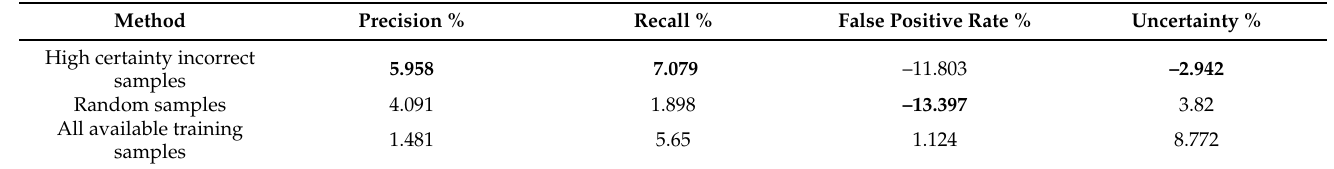
Table 4. Comparison of Average Improvement for Pre- and